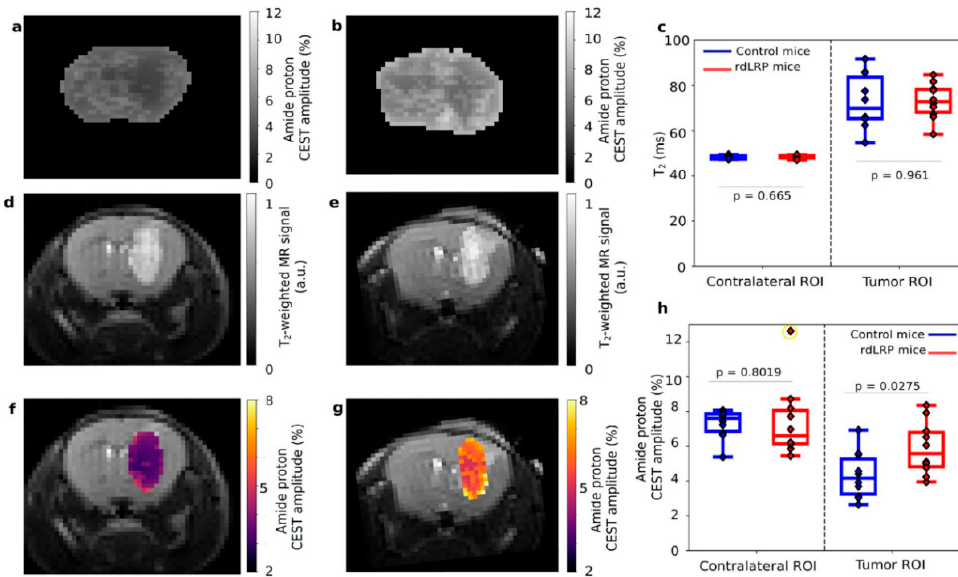
Figure 5. In vivo imaging of the rd LRP. ( a , b ) The amide proton CEST amplitudes of glioma cells that did not express rd LRP ( a ) and expressed rd LRP ( b ) in mouse brain. ( c ) Comparison of the T2 relaxation time of the two groups. The results showed no significant difference, and there was edema in the tumor area. ( d , e ) T2-weighted imaging corresponding to ( a , b ) respectively. ( f , g ) Overlay of the amide proton CEST contrast (obtained using a frequency selective saturation pulse ( a , b )) on the ( d , e ) image. ( h ) Comparison of CEST amplitudes of amide proton. CEST signal increased significantly in rd LRP group. Reproduced with permission from Ref. [41], 2020.